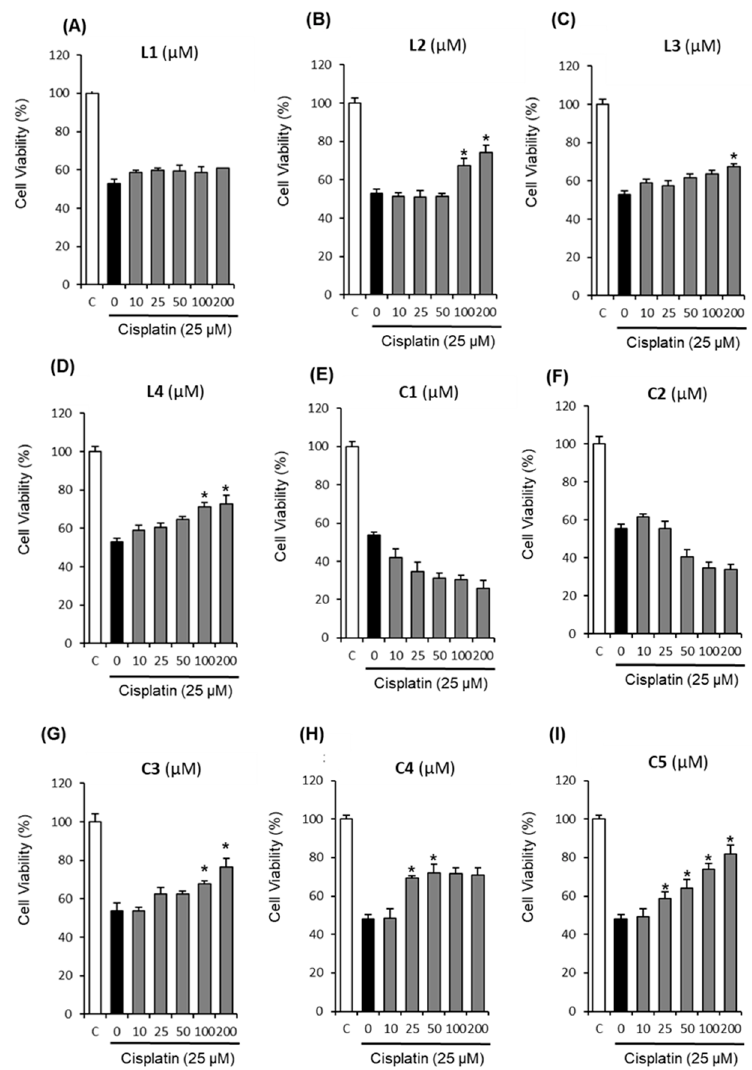
Figure 1. Comparison of the effects of nine triterpenoids on viability LLC-PK1 cells exposed to 25 μ M cisplatin for 24 h by MTT assay. ( A ) Effect of L1 against cisplatin-induced LLC-PK1 cell Death in LLC-